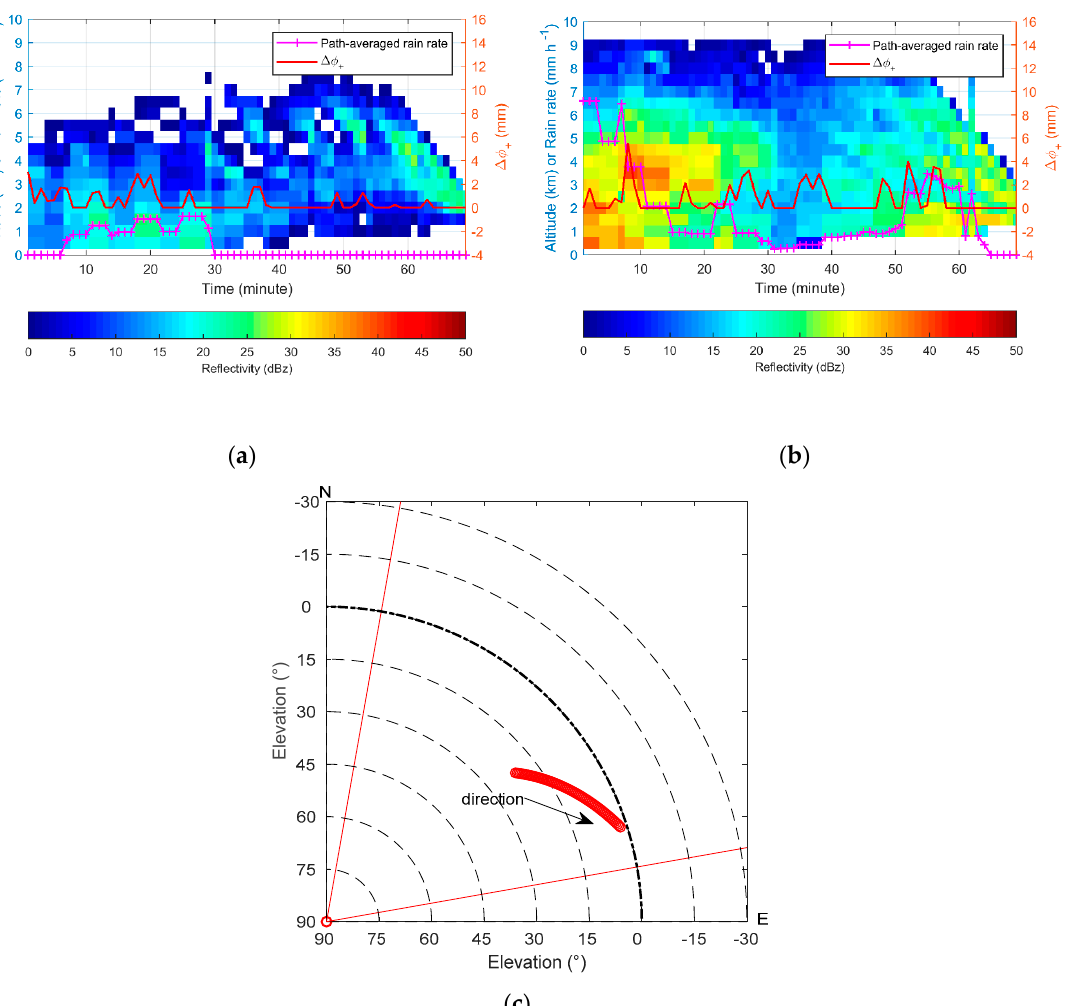
Figure 7. Examples of phase shift (red solid line with values indicated by the right y axis) from two rainy days compared with radar reflectivity (interpolated along GPS rays, whose value is shown by color scale and height is represented by left y axis) and path-averaged rain rate (“pink + ” line with values indicated by the left y axis) calculated from radar reflectivity: ( a ) on 6 July 2015; ( b ) on 10 August 2015; ( c ) sky plot of G27 at this selected time.